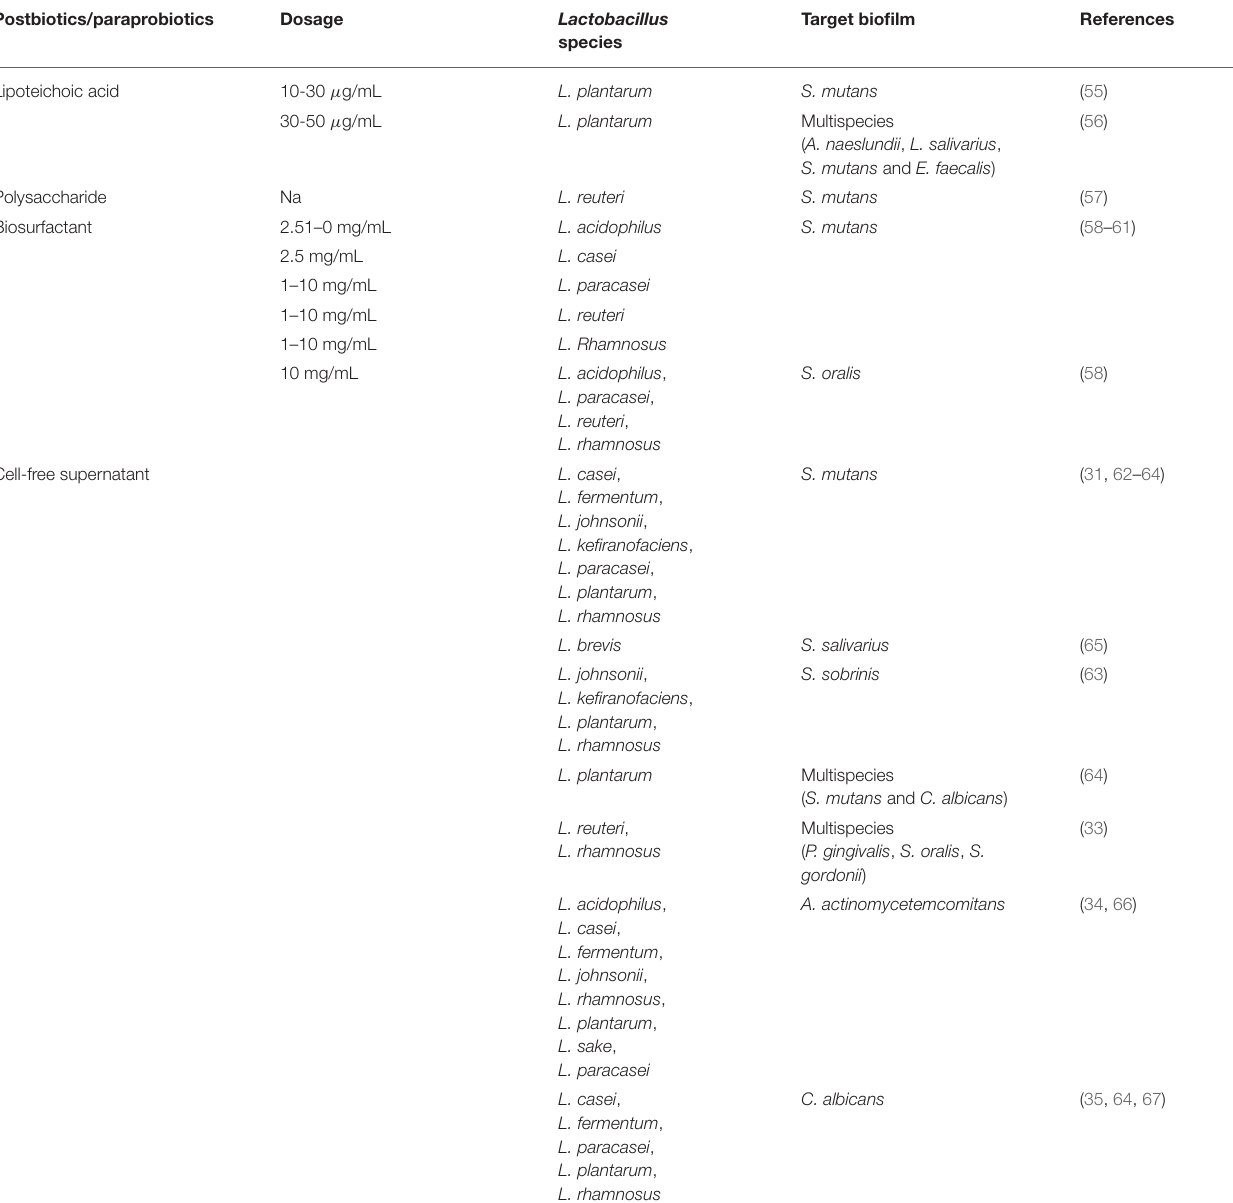
TABLE 2 | Postbiotics/paraprobiotics from Lactobacillus spp. exhibiting in vitro anti-biofilm activity against pathogens involved in oral biofilm-related diseases.